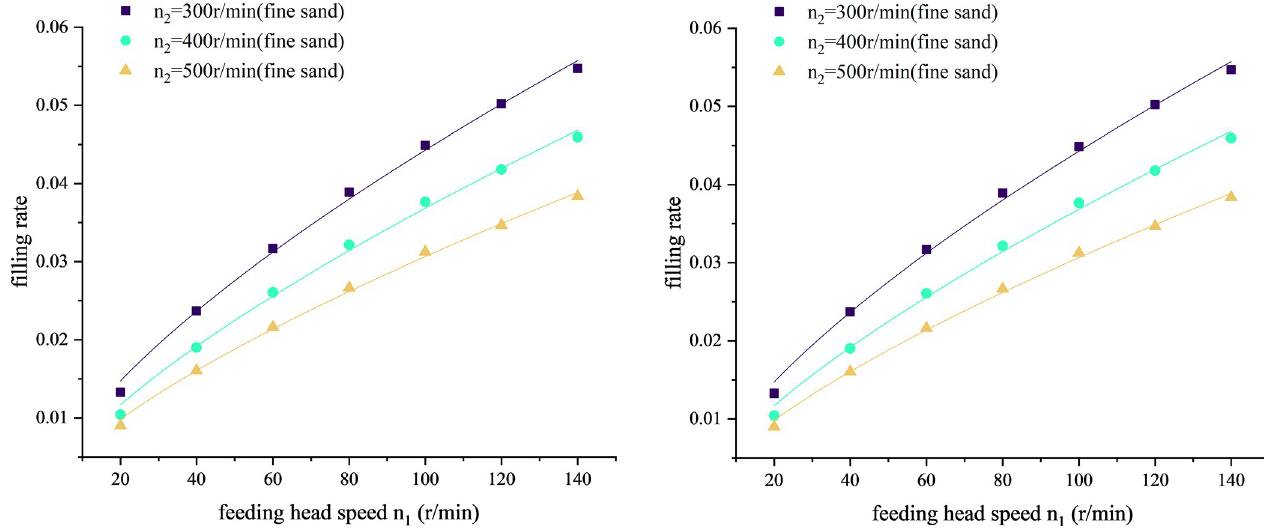
Fig 9. Curve of filling rate versus screw speed n 1 . (A) Material: sand. (B) Material: soybean.